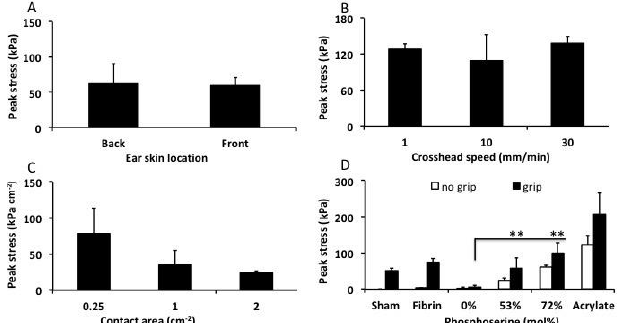
Figure 5. Lap shear strength of PMCs under varied testing conditions. ( A ) The bond strength of αTCP2.1 PMCs applied to porcine skin obtained from either the rostral (front) or caudal (back) portion of the ear. ( B ) Bond strength of αTCP2.1 PMCs tested at a crosshead speed of 1, 10, or 30 mm per minute. ( C ) Bond strength of αTCP2.1 PMCs applied to porcine skin of different sizes (overlap area). ( D ) The effect of using universal grips (black bars), compared to samples that were appositioned without grips (white bars) on the observed bond strength for each material. All samples contained 60 mol% of phosphoserine, unless otherwise indicated, and were cured for 90 min. Each αTCP, i. e., αTCP2.1, refers to the average particle size (D0.5, surface, in micrometers) of the calcium salt portion of PMC. * and ** indicate p < 0.05, and p < 0.01, respectively, in comparison to samples with a 1 cm 2 contact area ( C ), or between grip and no grip samples ( D ). Each data point and group represents a sample size of three ( n = 3), except in Figure 5A, which contained six samples per group ( n = 6).